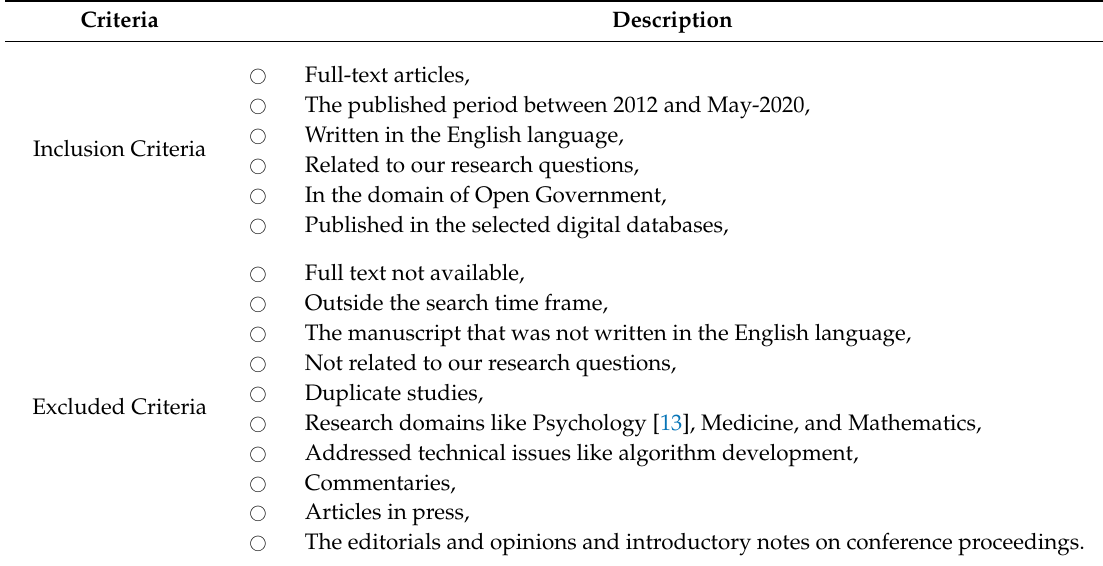
Table 1. Inclusion and Exclusion